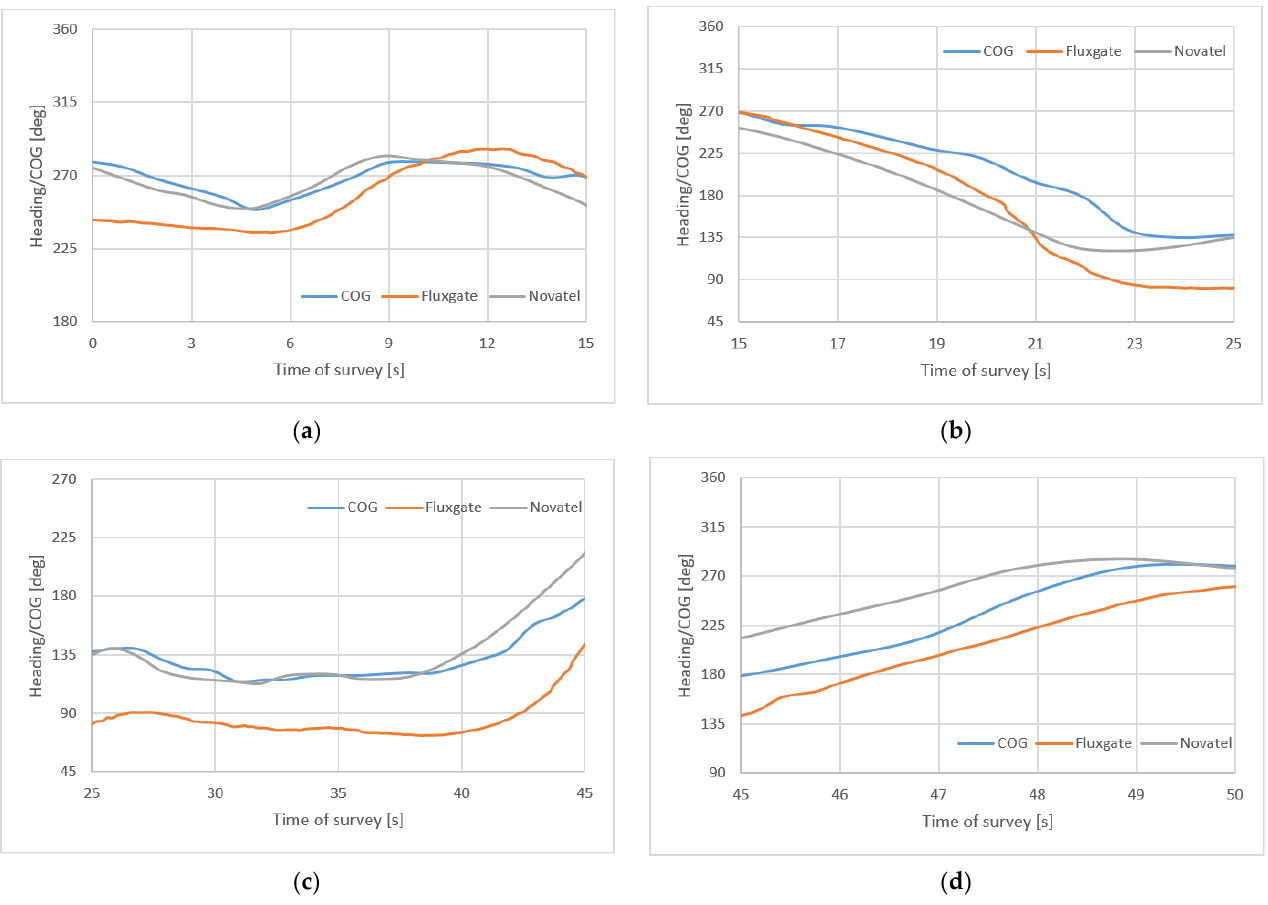
Figure 11. Headings and COG recordings of two first profiles ( a , c ) and two first turnings ( b , d ).